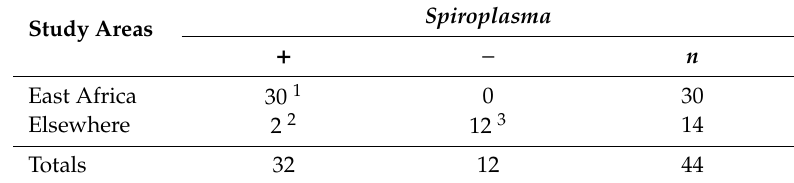
Table 3. Geographical comparison of sites giving evidence of Spiroplasma presence 1 in D. chrysippus . Study